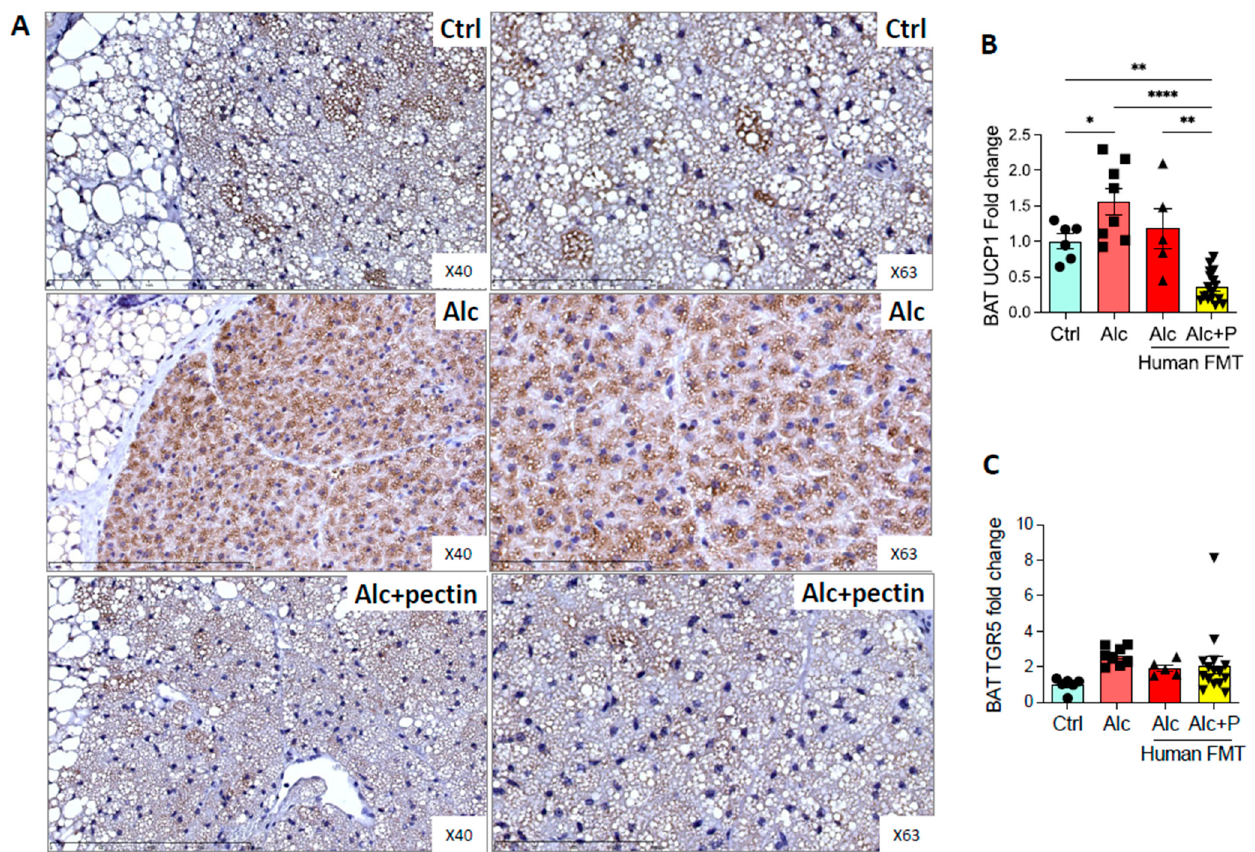
Figure 8. Brown adipose tissue activation in alcohol-fed mice is reversed by pectin. Control (Ctrl) and alcohol-fed (Alc) mice received a Lieber DeCarli diet with isocaloric maltodextrin or alcohol, respectively. Pectin-treated mice (Alc + p ) received 6.5% pectin in addition to 5% ethanol. Human fecal microbiota transfer (FMT) groups received the microbiota of a patient with alcoholic hepatitis. Representative histological images of brown adipose tissue (scale bar = 100 μ m and 200 μ m) by uncoupling protein 1, UCP1 immunohistochemistry ( A ). Quantification of mRNA levels of UCP1 ( B ) and TGR5 ( C ) of brown adipose tissue by qPCR. * p < 0.05, ** p < 0.01, **** p < 0.0001.